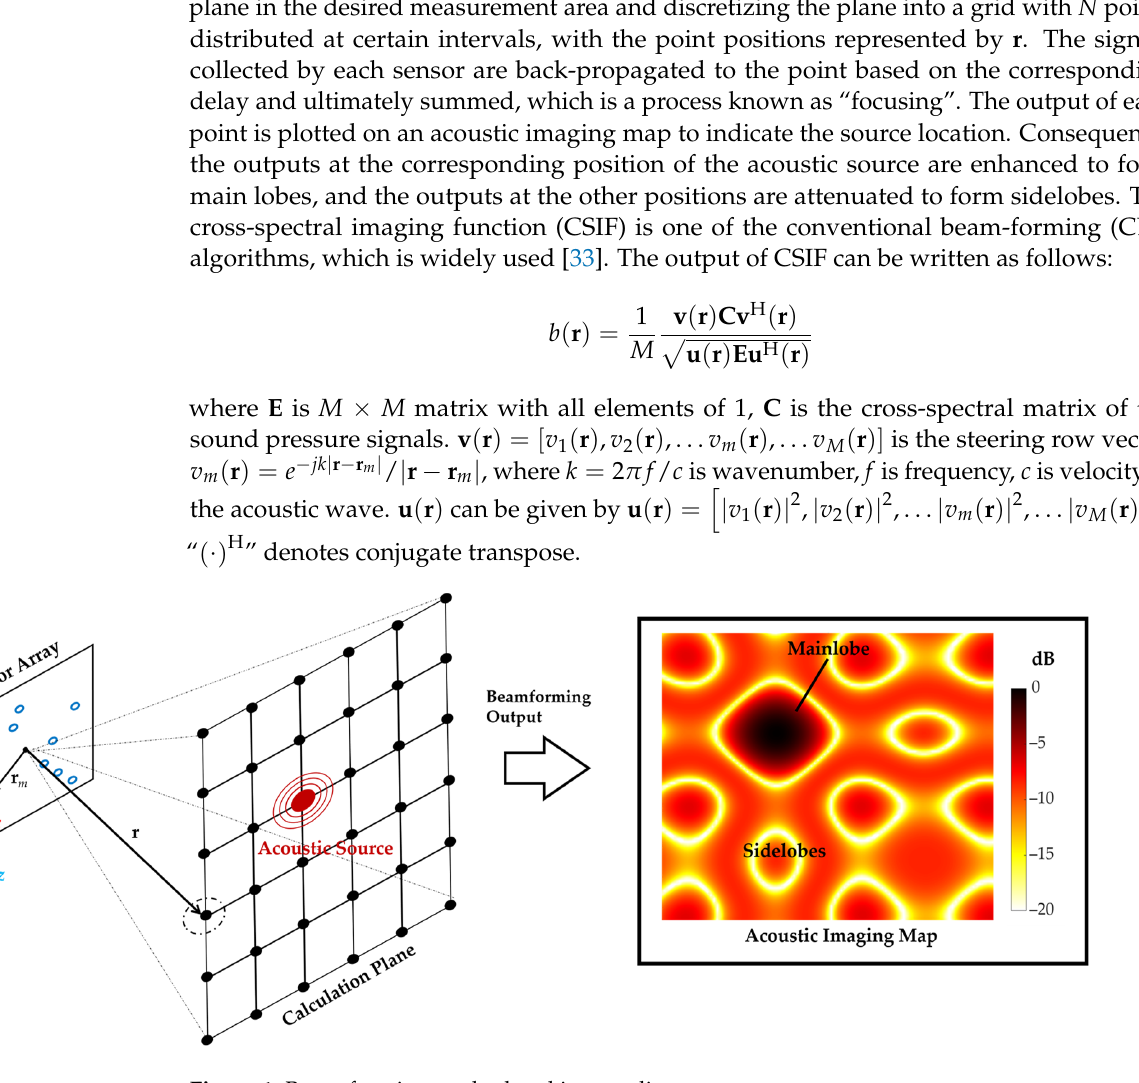
Figure 1. Beam ‐ forming method and its coordinate system. Figure 1. Beam-forming method and its coordinate